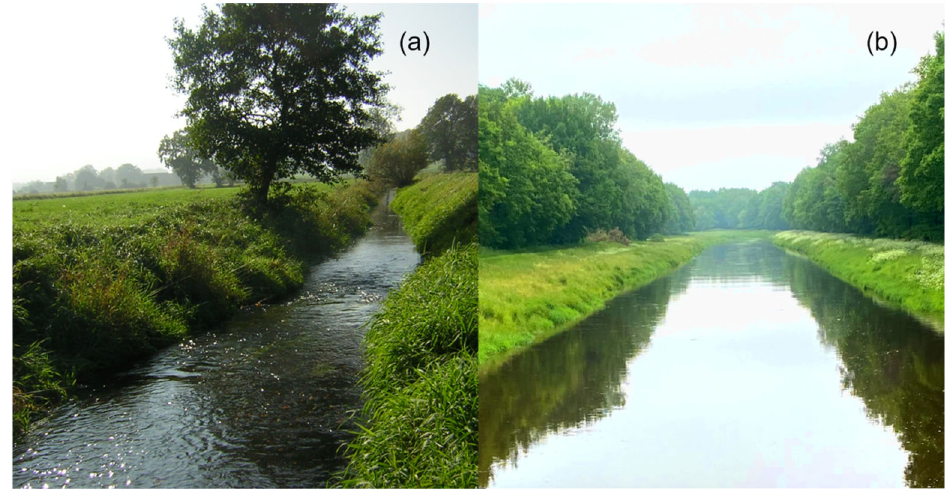
Figure 2. The Hase River in the ( a ) upper course (type 6, “fine material rich, carbonaceous highland streams”; source: Roman Rittner); ( b ) lower course (type 15, “sand and loam associated lowland rivers”; source: Joachim Härtling).